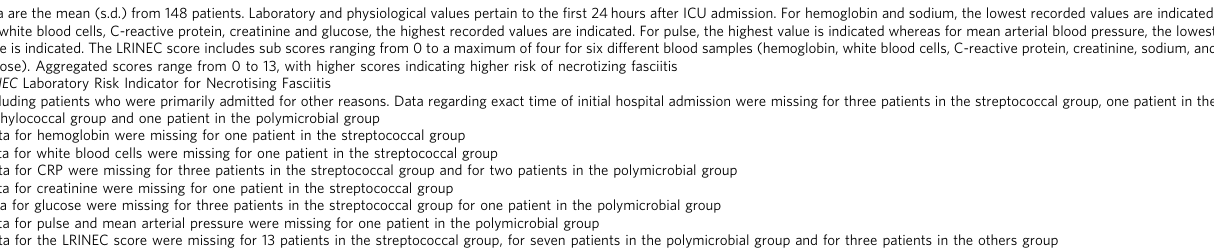
(Table 1, Supplementary Figure 8b). As the frequency of monomicrobial NSTIs caused by bacteria other than Strepto- coccus spp. was too low to enable statistical analysis, we ran- domly selected a set of monomicrobial Streptococcus spp. NSTI biopsies ( n = 17) as well as a set of polymicrobial NSTIs ( n = 22) for in-depth transcriptional pro fi ling (Supplementary Data 3 and Fig. 2). A strong correlation between the relative contribution of identi fi ed bacterial genera to the transcriptional activity and the relative abundance of these genera within the NSTIs microbial communities as identi fi ed by 16S rRNA gene sequencing was observed (Supplementary Figure 9a, b). The bacterial transcrip- tional pro fi le indicated expression of a broader spectrum of functionalities in polymicrobial than in monomicrobial NSTIs (Fig. 3, Supplementary Data 5). Analysis of highly transcribed functionalities indicated that speci fi c pathways, such as purine ribonucleoside salvage or glycine catabolism, were only expressed by a fraction of the polymicrobial community, as evidenced by low associated alpha-diversity of the genus-level transcriptional contribution to these functionalities (Supplementary Figure 9c). This observation may indicate functional specialization of the co- occurring genera within the bacterial communities of poly- microbial NSTIs. Comparative analysis of streptococcal versus polymicrobial NSTIs indicated that carbohydrate metabolic pathways including lactose (GO:0005990), trehalose (GO:0005993), and galactose metabolism (Supplementary Fig- ure 10) and carbohydrate transport (GO:0015771, GO:0008645, GO:0034219) were strongly expressed in monomicrobial NSTIs, while amino acid transport (GO:0006865, GO:0015813) and metabolism (Supplementary Figure 10), and protein processing